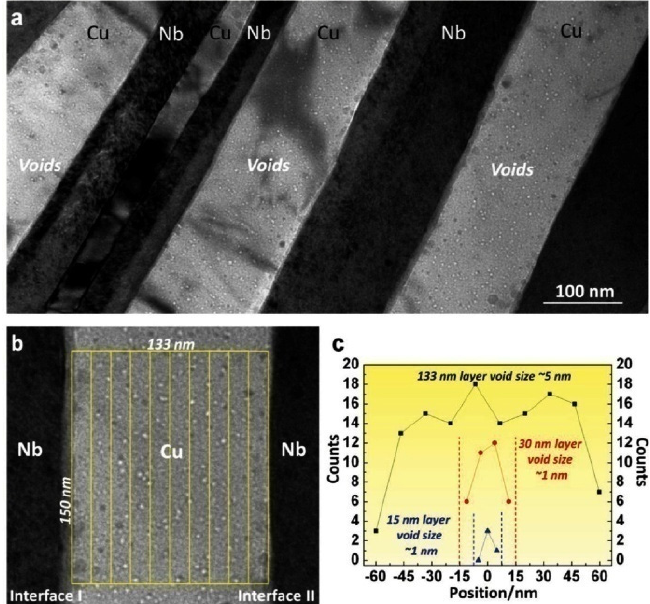
Figure 3. ( a ) Irradiation ‐ induced voids in Cu layers in irradiated accumulative roll bonding